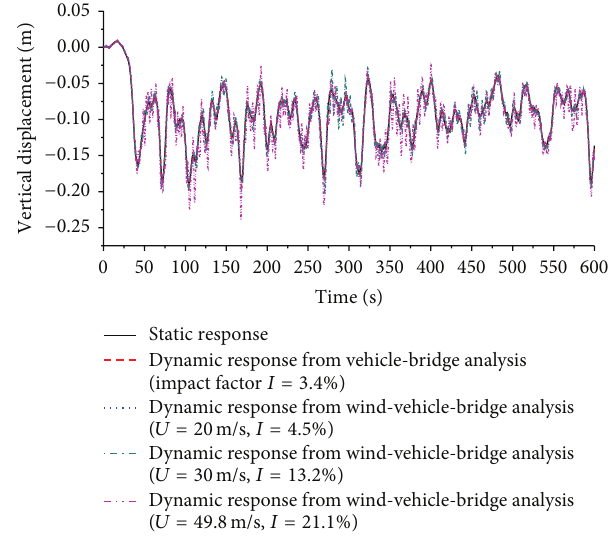
Figure 18: Time histories of vertical displacement responses caused by the traffic flow at point C in a windy or windless environment.